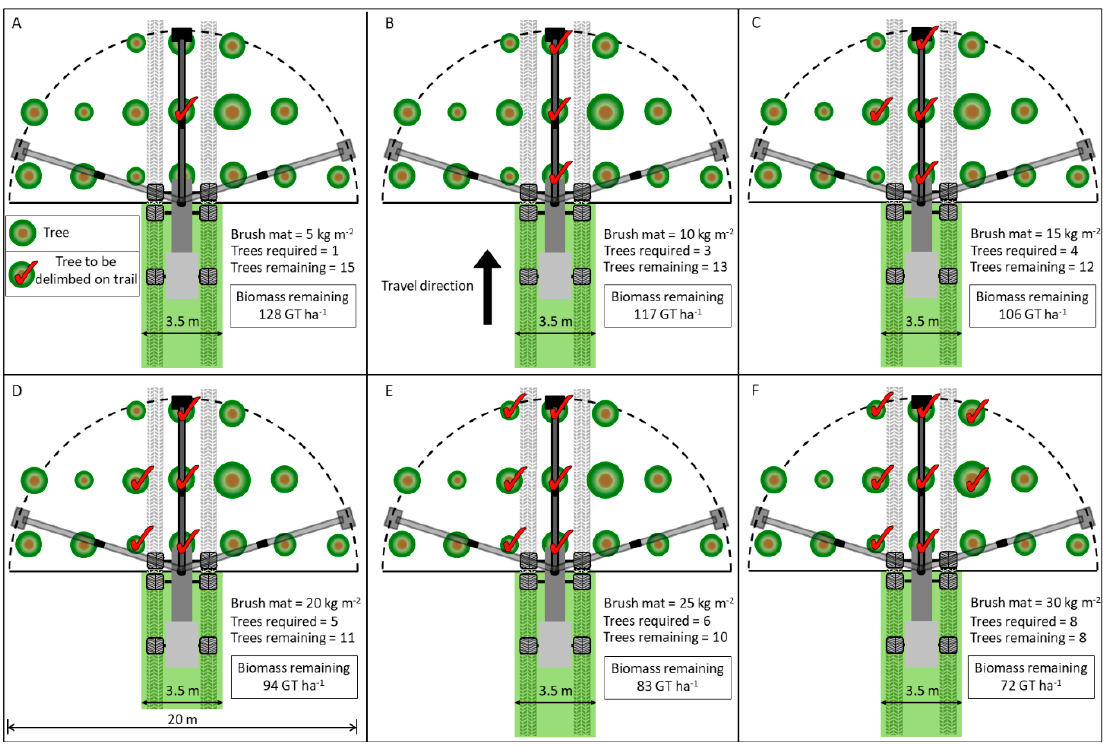
Figure 1. Visual representation of the effect of different brush mat requirements on the number of trees to be delimbed on the machine operating trail and corresponding number of trees remaining for other uses based on the area covered by the sweep of a 10 ‐ m ‐ long harvester boom. Scenarios presented are for stand 2 (black spruce plantation) and relate to a trail width of 3.5 m and spacing of 20 m between trail centerlines.